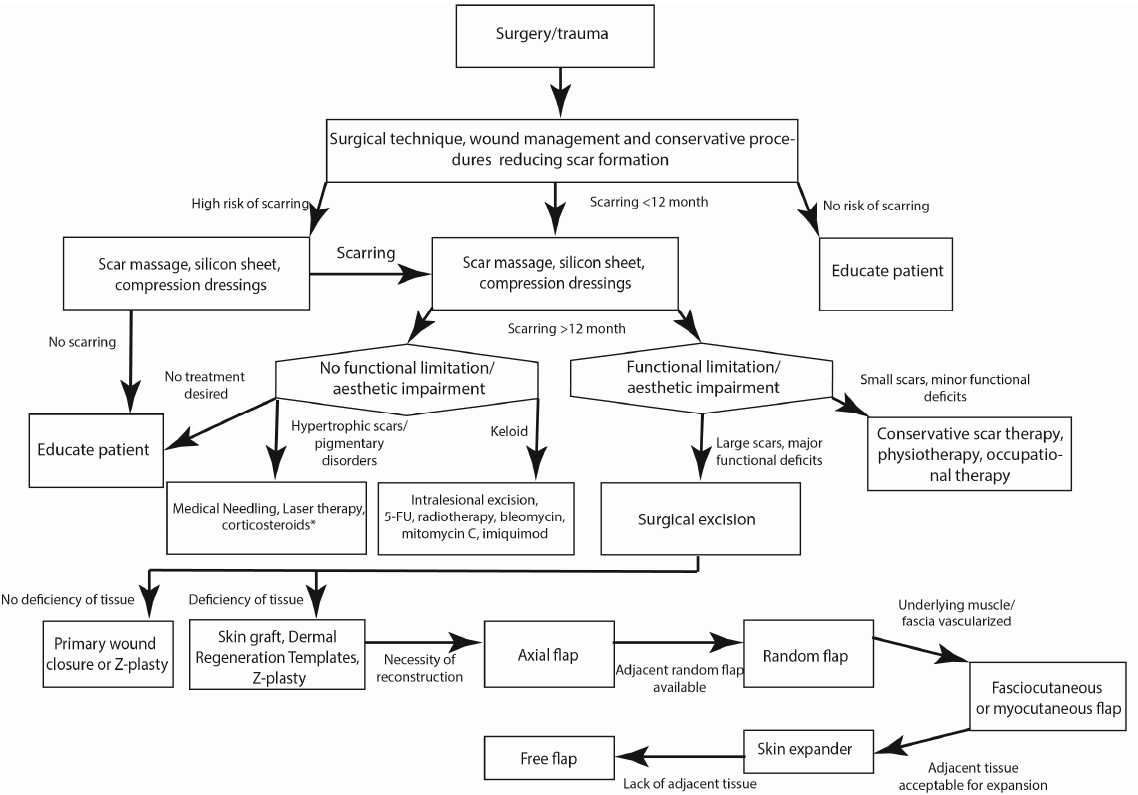
Figure 10. Algorithm for the treatment of scars.